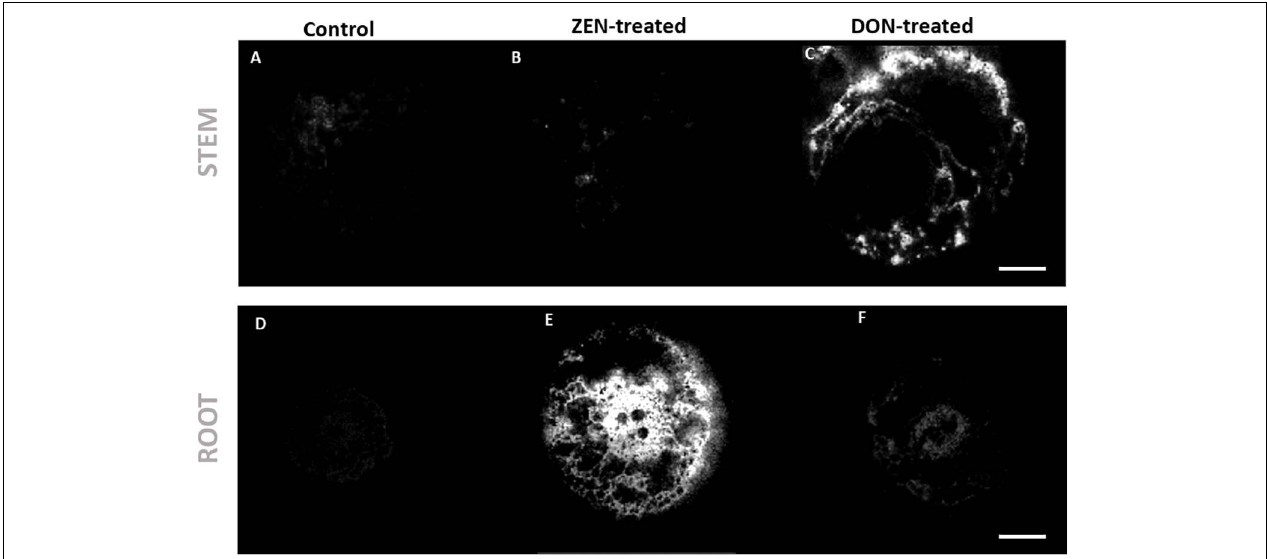
FIGURE 4 | Distribution of coumaroylagmatine in root and culm samples. The hydroxycinnamic acid amide coumaroylagmatine ([M + H] + , m/z 277.1660) was found to be spread in the root of the ZEN-treated sample (E) , while it was localized in the outer leaf sheath of DON-treated wheat culm (C) . (A–C) Wheat culms. (A) Control; (B) ZEN-treated; (C) DON-treated. (D–F) wheat roots. (D) control; (E) ZEN-treated; (F) DON-treated. AP-SMALDI MS images were obtained at imaging step sizes of 7 µ m for roots and 20 µ m for culms and normalized to the total ion current on a 0-60% intensity scale. Scale bars: 200 µ m for roots and 500 µ m for culms.